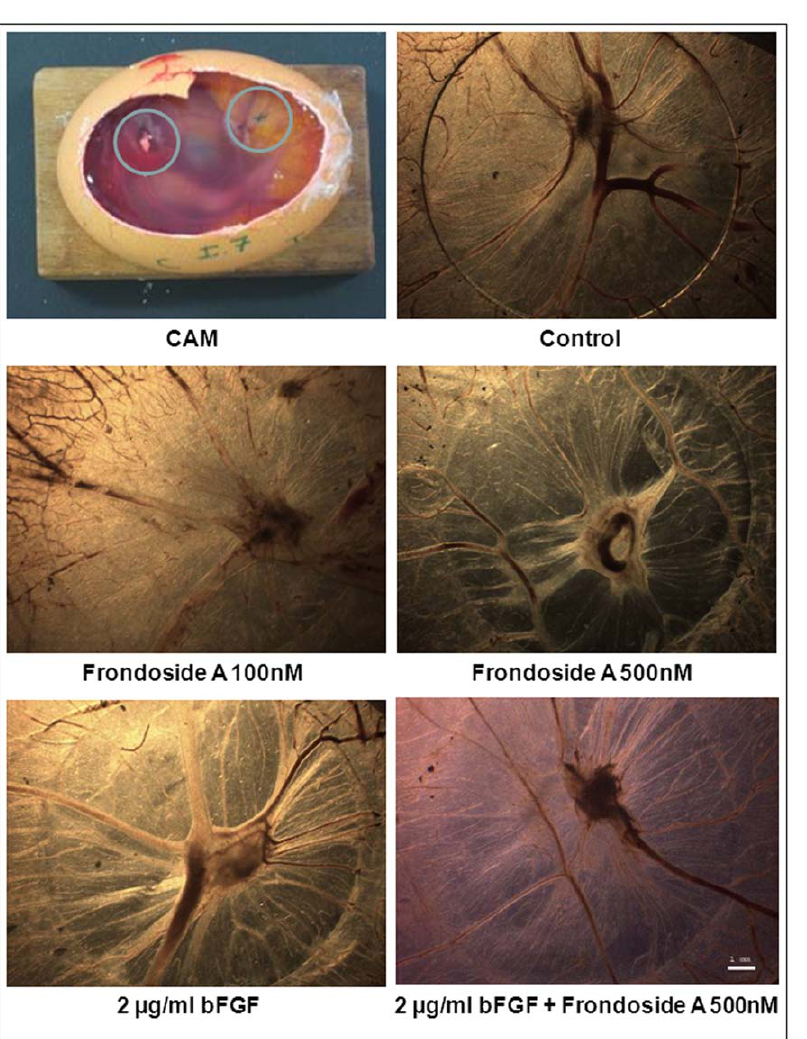
Figure 5. The anti-angiogenic activity of Frondoside A in the Chorioallantoic membrane (CAM) assay invivo : CAM was treated with control (serum-free medium), 100 nM Frondoside A, 500 nM Frondoside A, 2 m g/mL bFGF, 2 m g/mL bFGF + 500 nM Frondoside A and the vascularization of test discs was photographed.